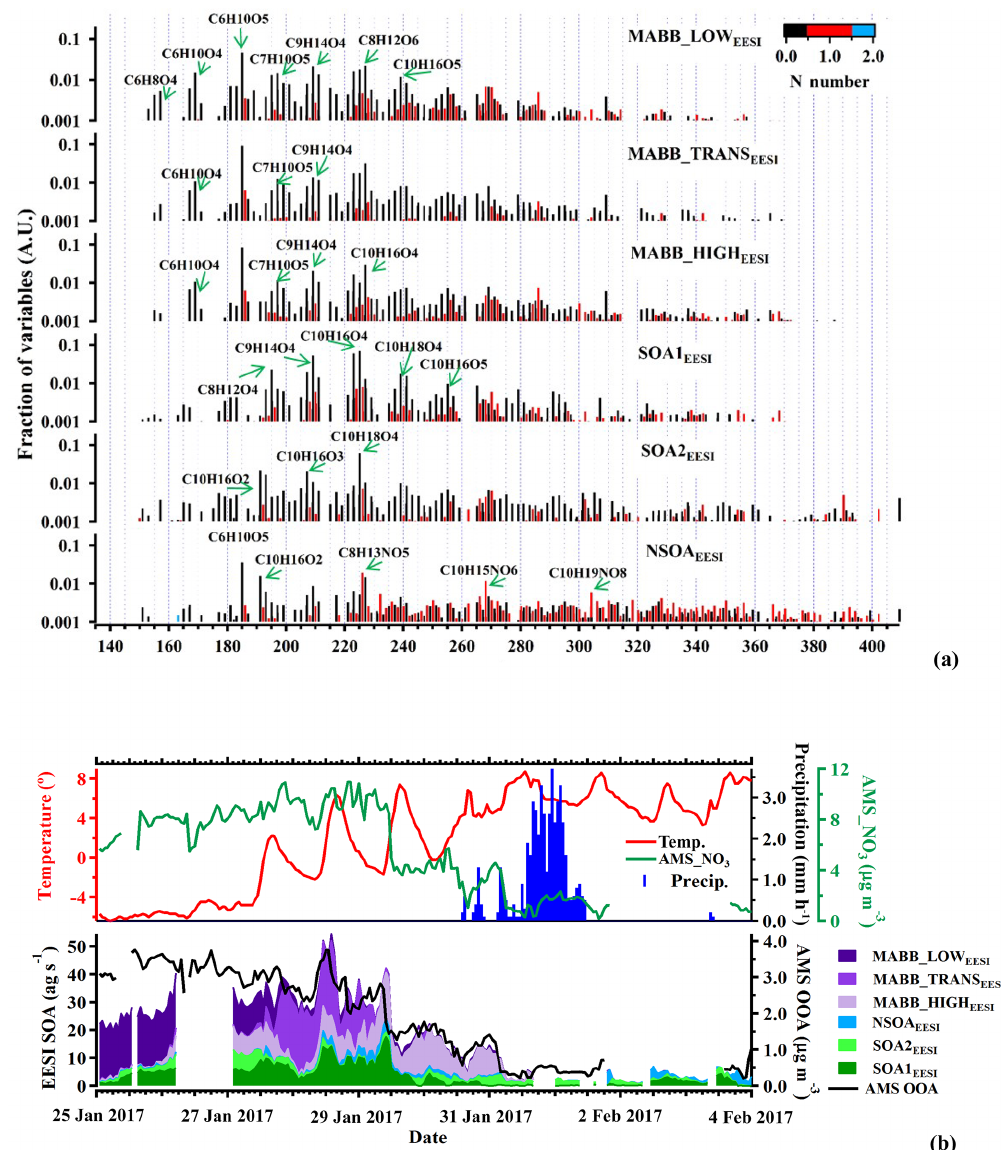
Figure 6. Factor profiles (a) and stacked time series (b) of the six EESI-TOF-MS SOA PMF factors, together with AMS OOA. Panel (b) also shows meteorological data. All EESI-TOF-MS data are plotted in mass flux (ags − 1 ), AMS data are in micrograms per cubic meter, and other units are included. Factor profiles (b) are molecular weighted and are normalized such that the sum of each profile is